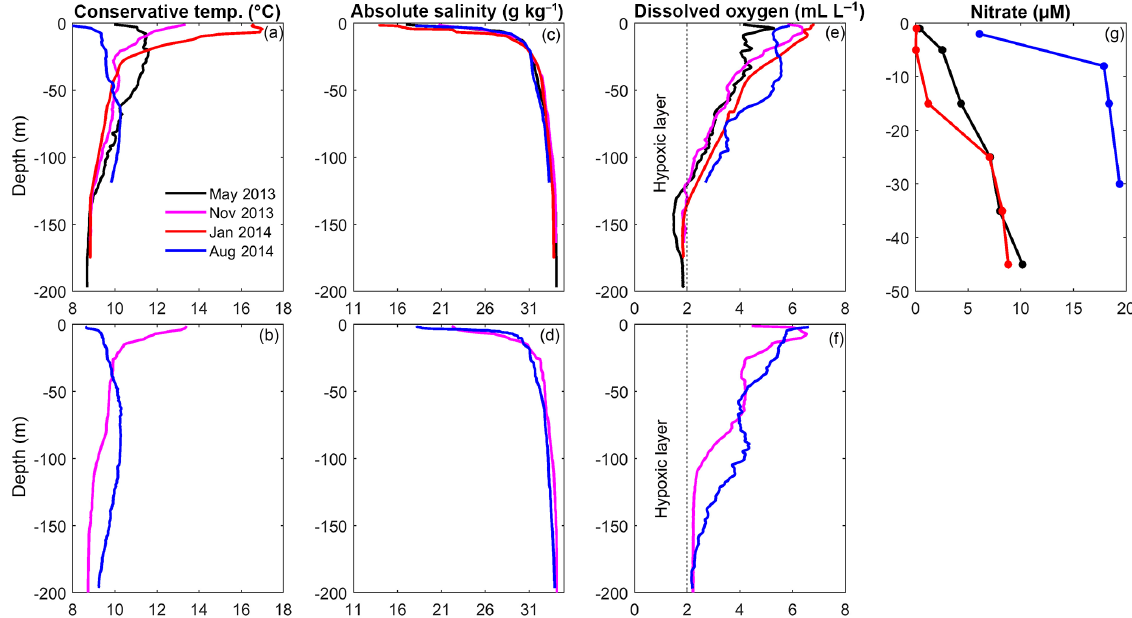
Figure 2. (a, c, e ,g) Profiles of temperature (a, b) , salinity (c, d) , dissolved oxygen (e, f) and nitrate (g) collected during different oceano- graphic campaigns in the northern central part of Puyuhuapi Fjord and (b, d, f) in the eastern region of the Jacaf